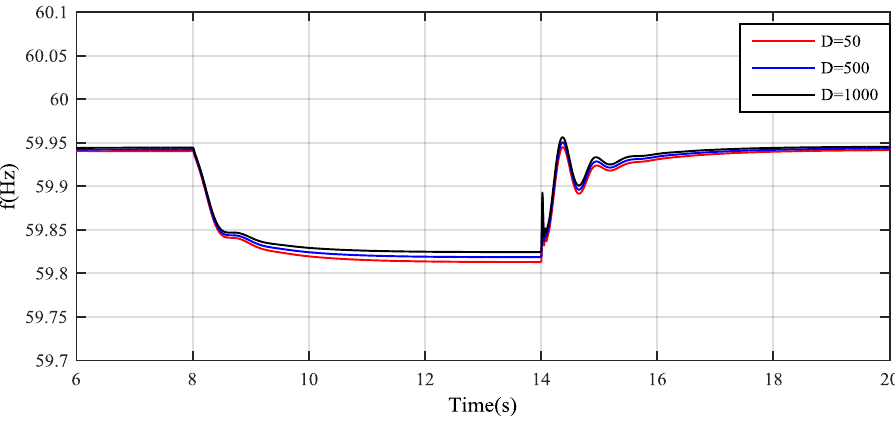
Figure 20. System frequency with different virtual damping factors.